Question: What type of chart is this?
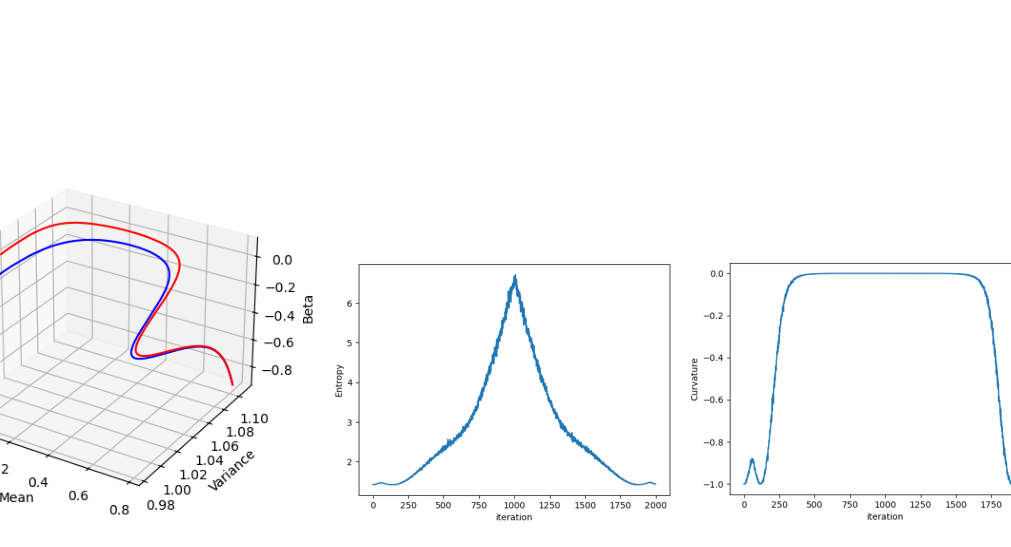
Answer: line